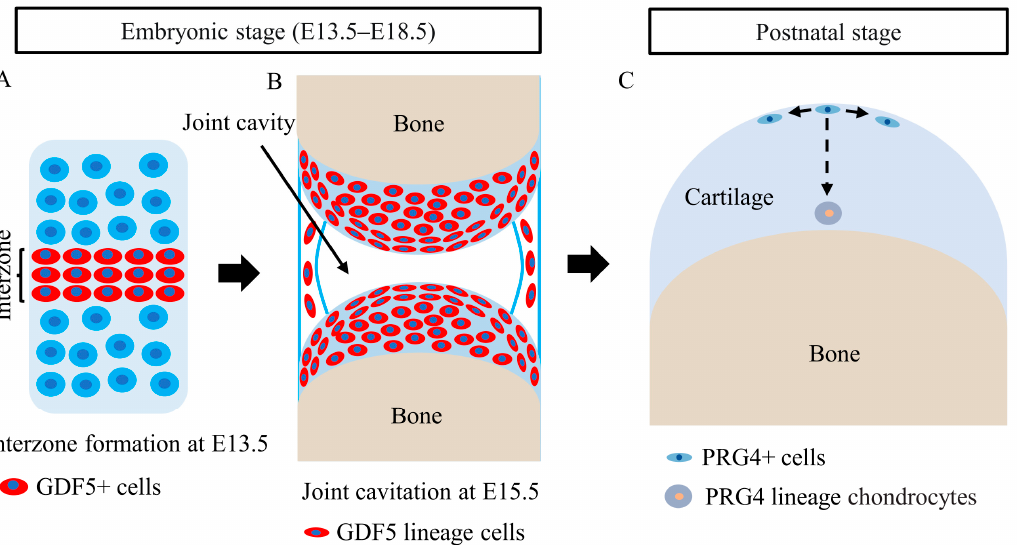
Figure 2. CSPCs in cartilage development. ( A ). GDF5+ cells constitute the interzone at the site of future joints. ( B ). During the embryonic stage, GDF5+ cells contribute to the formation of articular cartilage and other joint structures. ( C ). During the postnatal stage, PRG4+ cells in the SFZ are likely descendants of GDF5+ cells. PRG4+ cells in the SFZ are CSPCs that have self-renewing capacity to expand their population by symmetrical divisions, and PRG4+ cells in the SFZ give rise to the un- derlying layers of